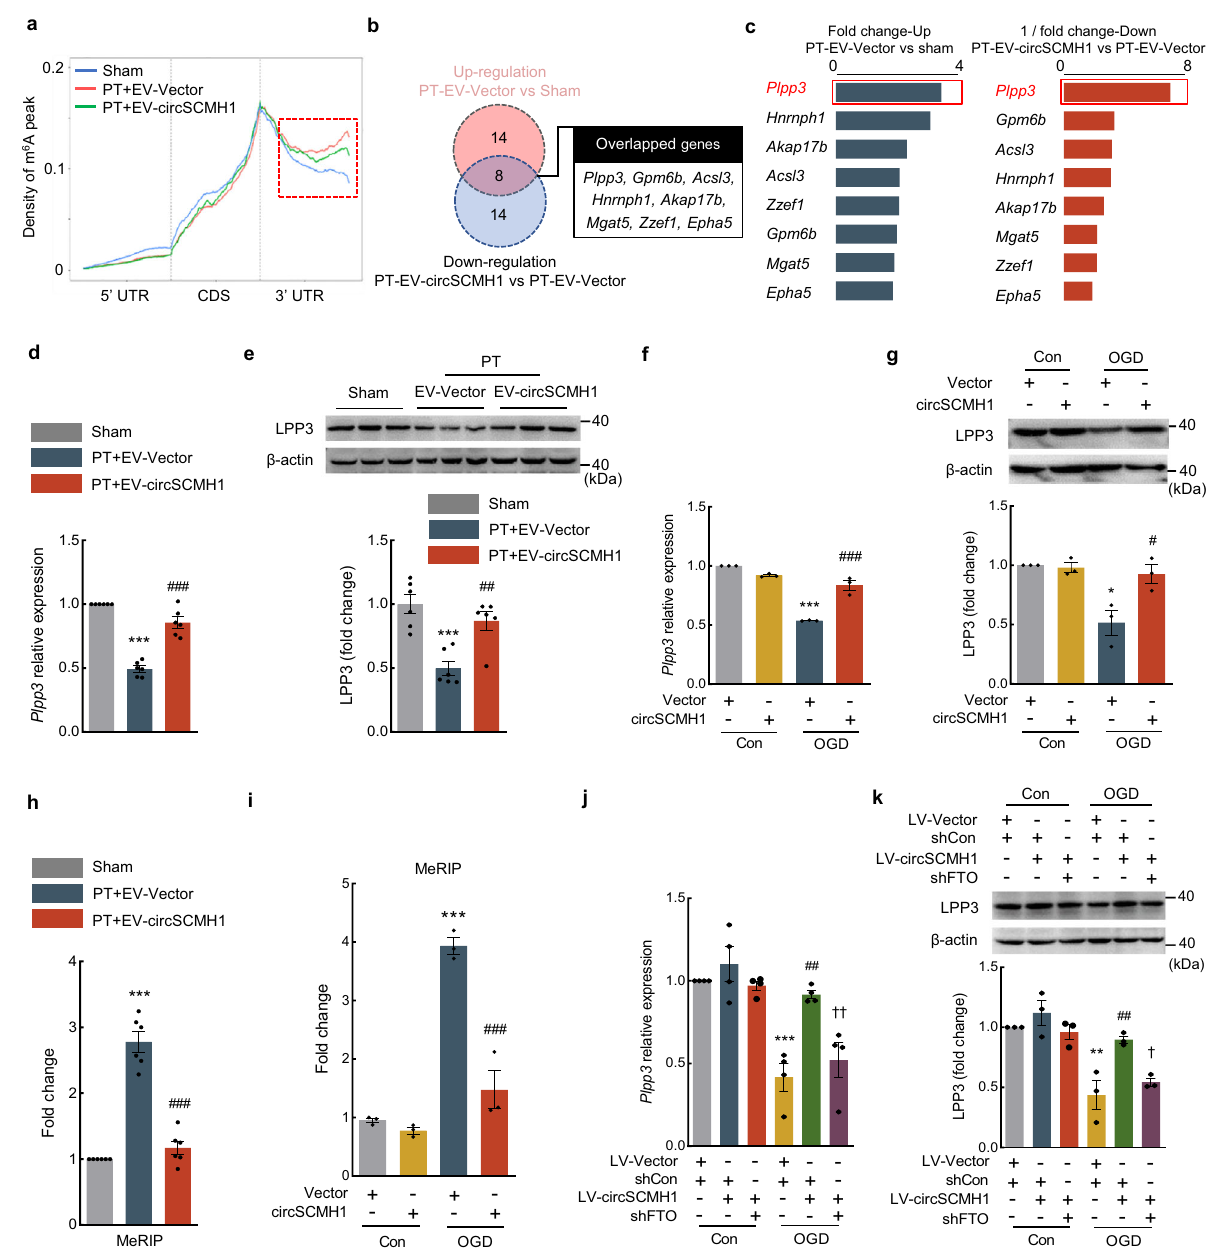
Fig. 5 | Plpp3 was one of the critical target genes of circSCMH1-regulated m 6 A modi fi cation in the peri-infarct cortex of PT mice. a Distribution of m 6 A peaks across 5 ′ -UTR, CDS, and 3 ′ -UTR of mRNA at day 14 after PT. b Venn diagram showing numbersof geneswith signi fi cantchangesinexpression(up:fold change ≥ 2, P <0.05; down: fold change ≤ 0.5, P <0.05, rescaled hypergeometric